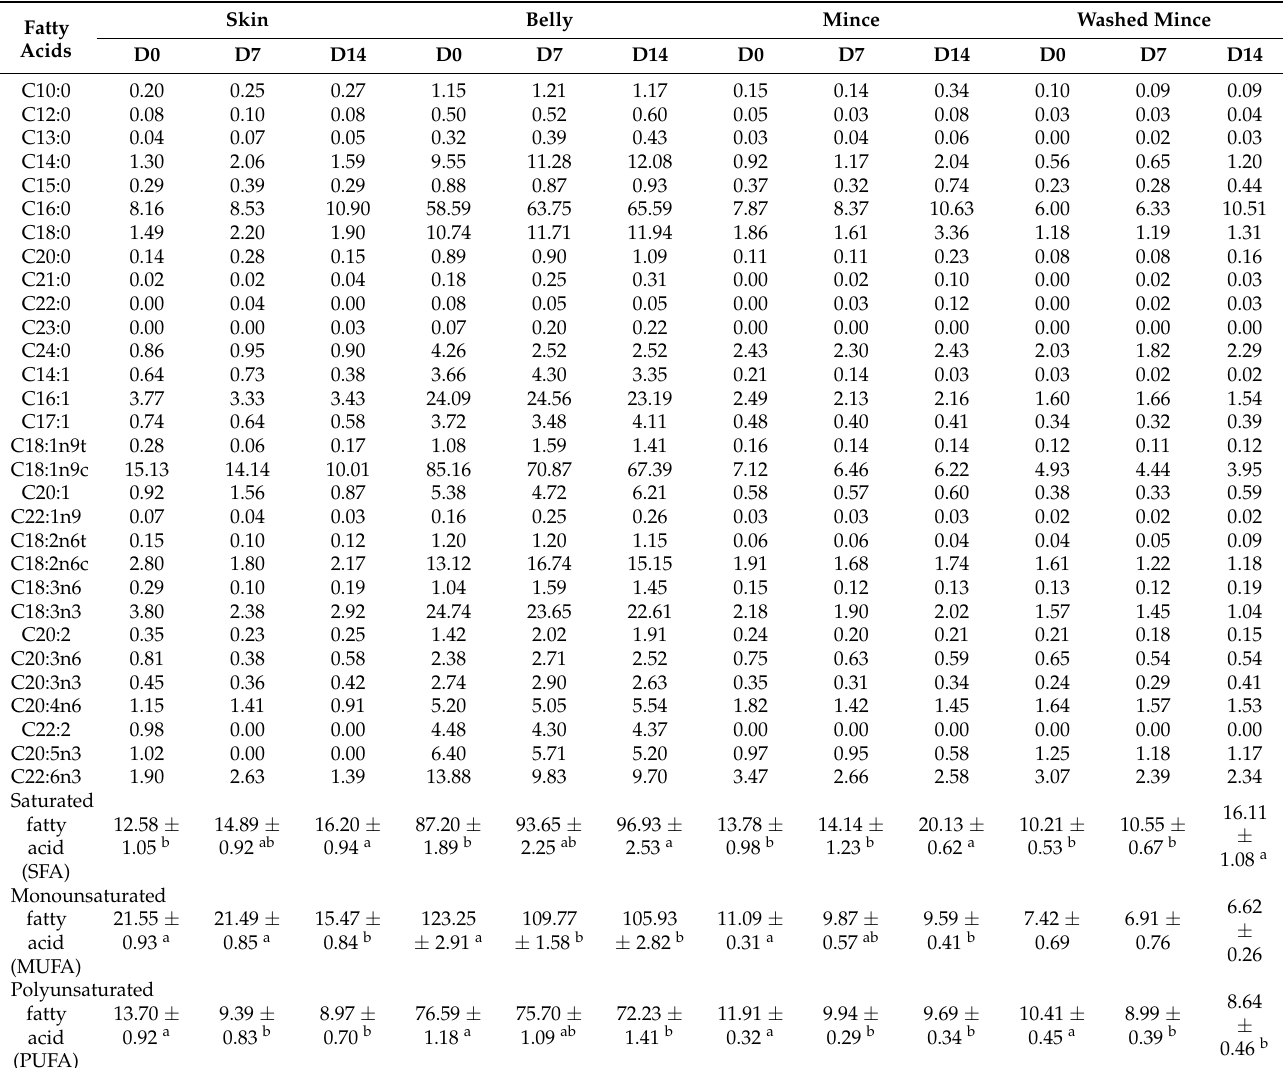
Table 2. Fatty acid contents of various tissues of silver carp during ice storage and their respective washed mince (mg/g dry